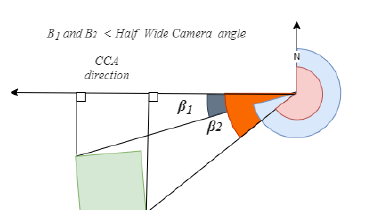
Figure 7. Tolerance angle necessary for each image can be found restricting by β1 and